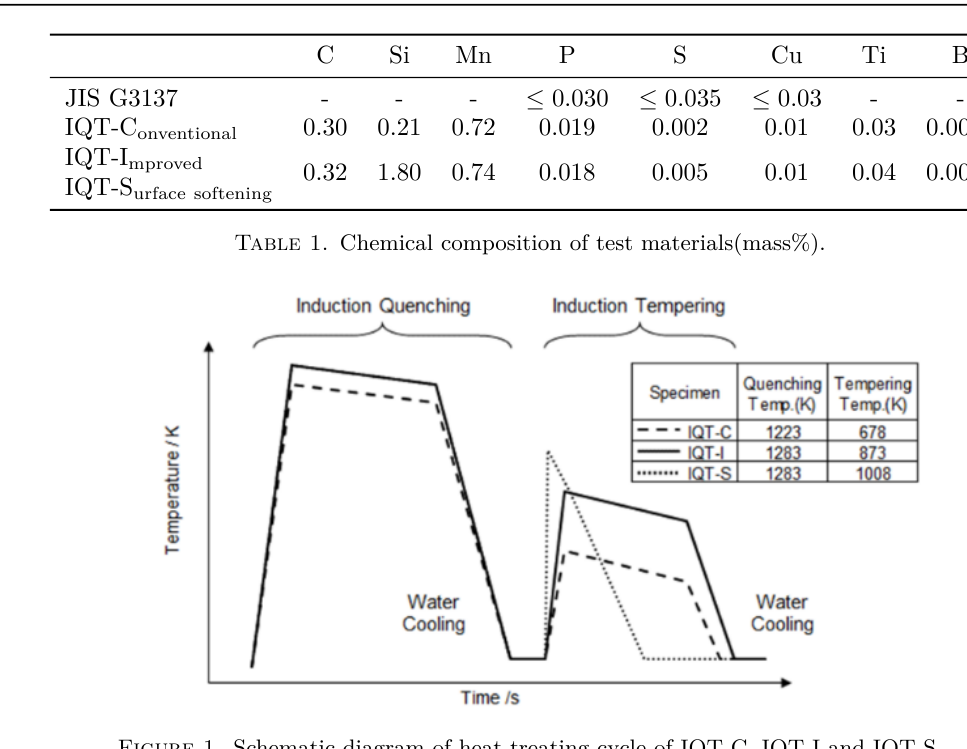
Figure 1. Schematic diagram of heat-treating cycle of IQT-C, IQT-I and IQT-S. Specimen